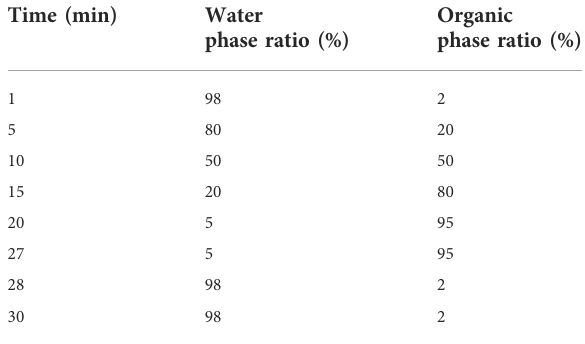
TABLE 2 Chromatographic